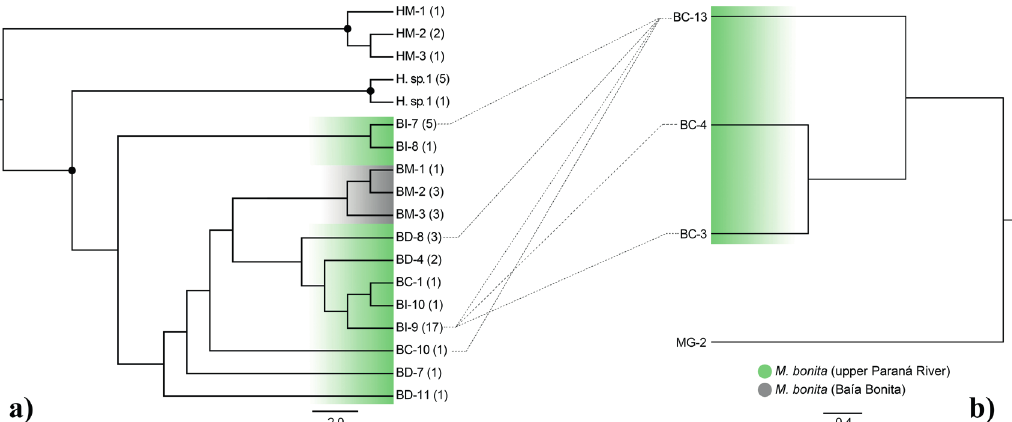
Figure 3 - Mirrored phylogenetic trees of mitochondrial ( a ) and nuclear ( b ) haplotypes constructed from specimens of Moenkhausia populations with different developmental levels of the lateral line. Hemigrammus marginatus (HM) and Hemigrammus sp. (H. sp. 1) were used as outgroup. The circles show the bootstrap values > 70. Numbers between brackets indicate the number of specimens with each haplotype. Dotted lines show the presence of a specific nuclear haplotype of a specific mitochondrial haplotype and vice versa. Sequences of intron 1 of the nuclear gene S7 were not obtained for samples without connection.